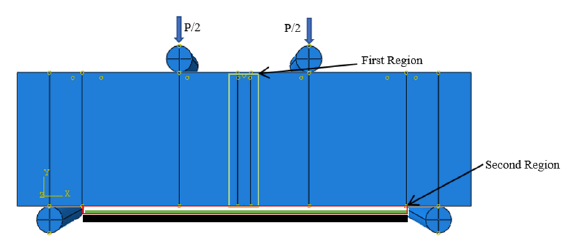
Fig. 9. Assign regions for techniques in FEA